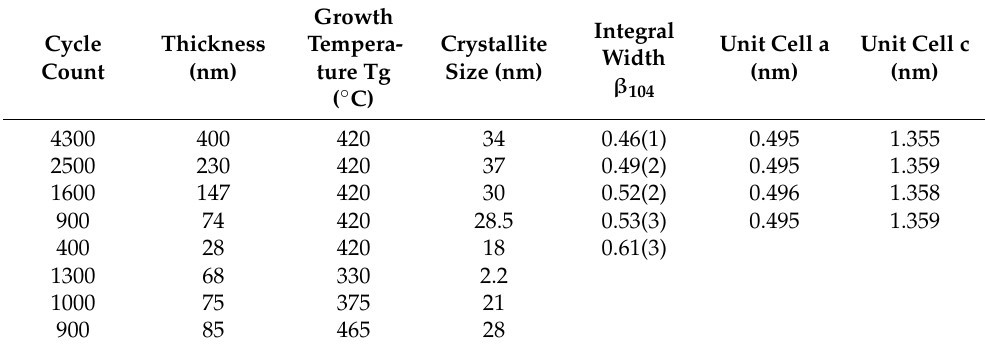
Table 1. Summarized results of X-ray analysis of ALD Cr 2 O 3 thin